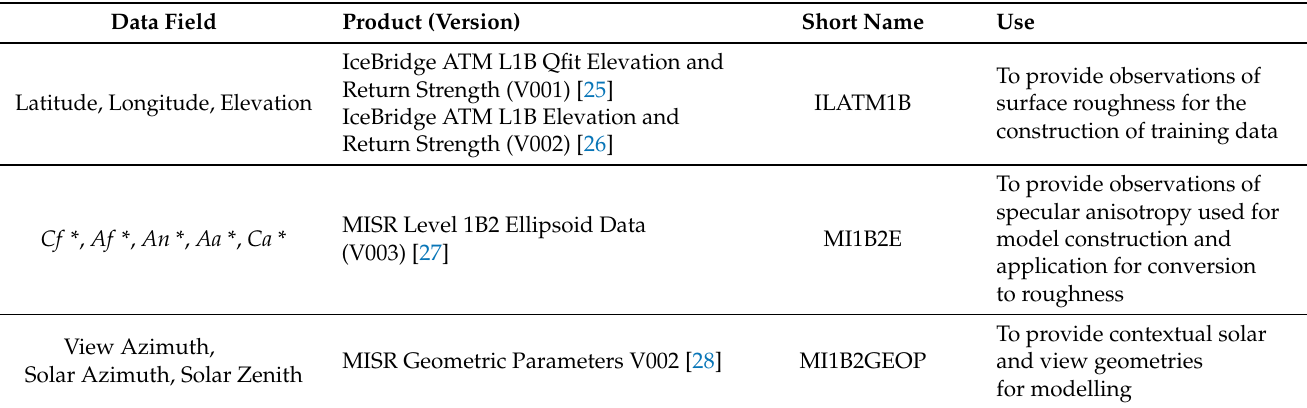
Table 2. A summary of the data fields, products, and versions used in this study and their respec- tive